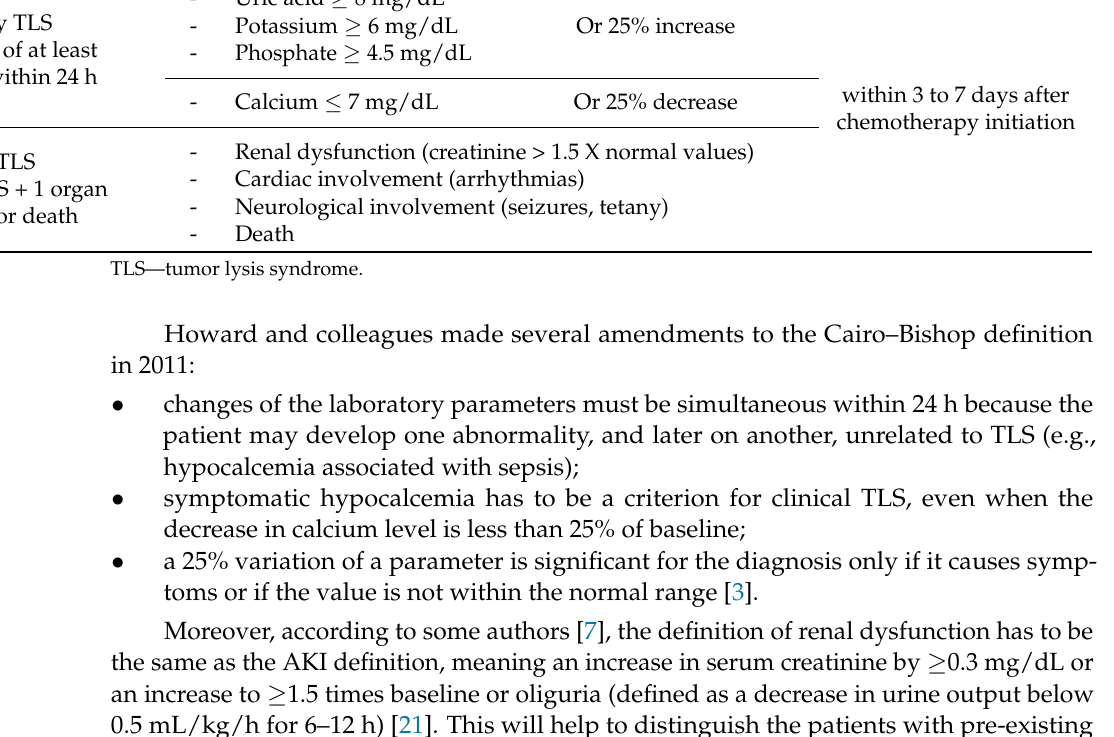
Table 1. Cairo–Bishop criteria for defining tumor lysis syndrome (modified after [20]). Cairo–Bishop Definition of Tumor Lysis